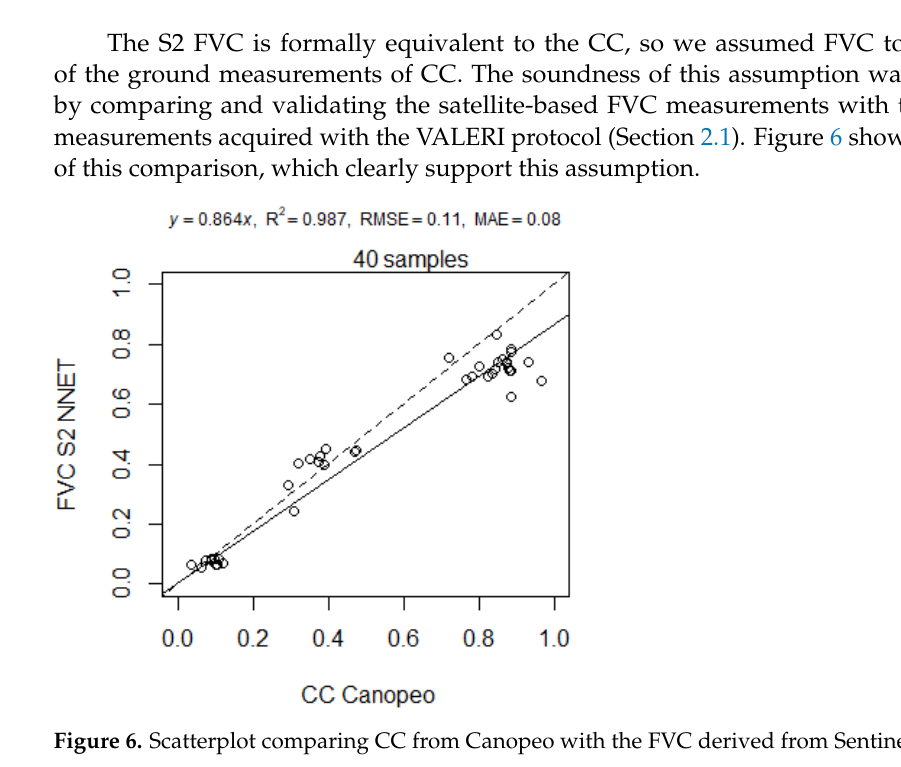
Figure 5. FVC maps derived from S2 acquisitions on 7 May 2021, 22 May 2021, 1 June 2021, and 4 June 2021 and the plot boundaries (in red).